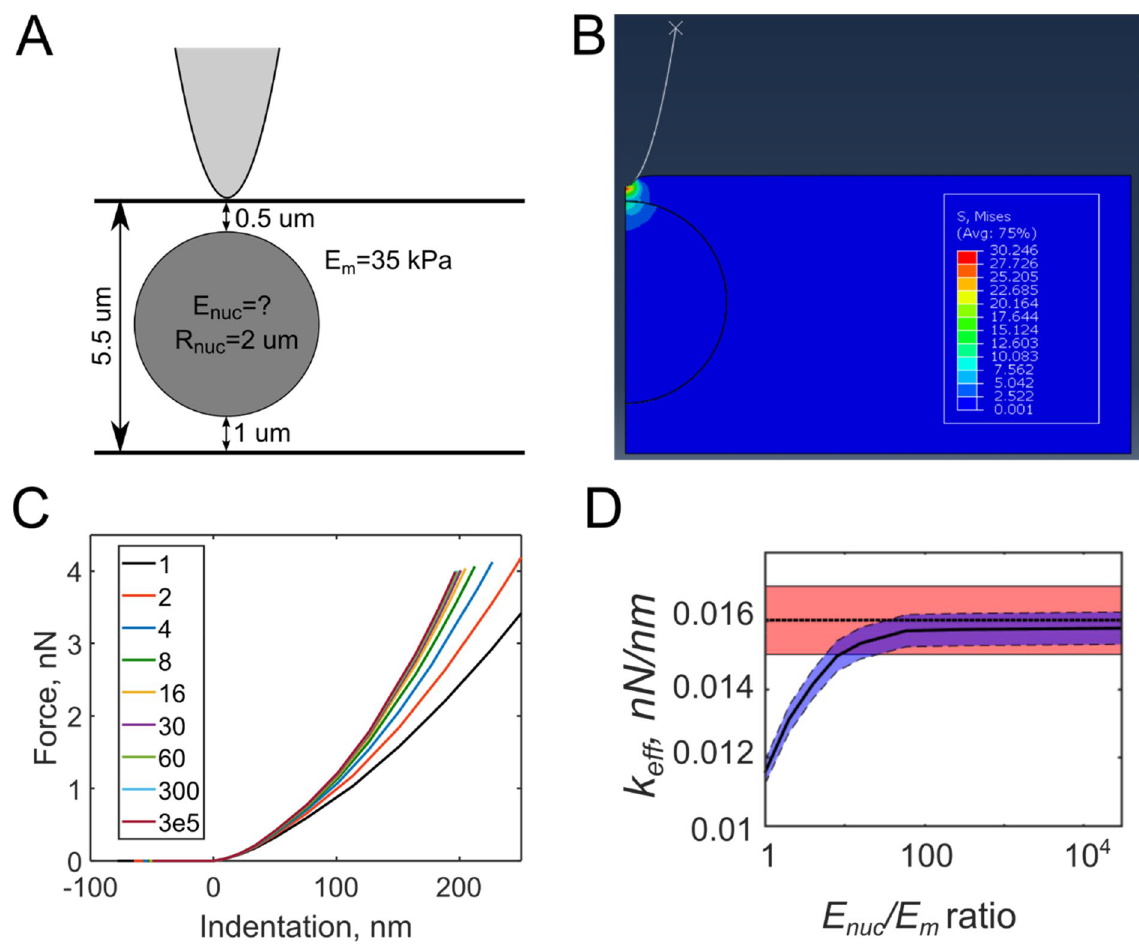
Figure 6. FEM analysis for estimating the mechanical properties of nucleoli. ( A ) Scheme of the FE model showing the dimensions extracted from the SDC images (the cantilever tip is not in scale). ( B ) Distribution of effective von Mises stress during the indentation over the nucleolus. ( C ) Simulated force-indentation curves, the legend shows E nuc / E m ratio. The curves went steeper as the ratio increased. ( D ) The effective local stiffness k eff (solid line) measured at the experimental value of force as a function of the E nuc / E m ratio. It approaches the experimental k eff value (dashed line, 0.016 ± 0.001 nN/nm, shaded area) at a high E nuc / E m ratio (> 100). The 10% error (shaded area) is based on variation in k eff value over nucleoli and surrounding